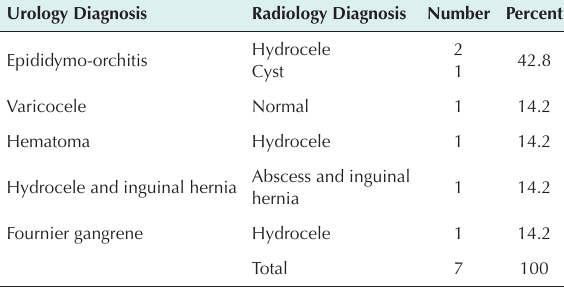
Table 1. Cases With the Lack of Contingency Between the Diagnosis of Performed Ultrasound by Radiology Assistants and